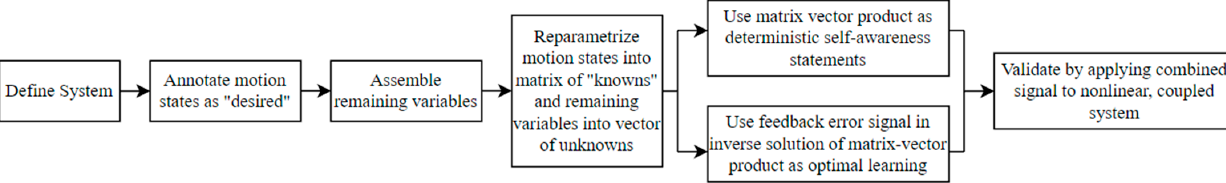
Figure 4. Topology of deterministic artificial intelligence [18] that is applied to an unmanned underwater vehicle system, as shown in Figure 5, whose actuators are powered by DC motors.